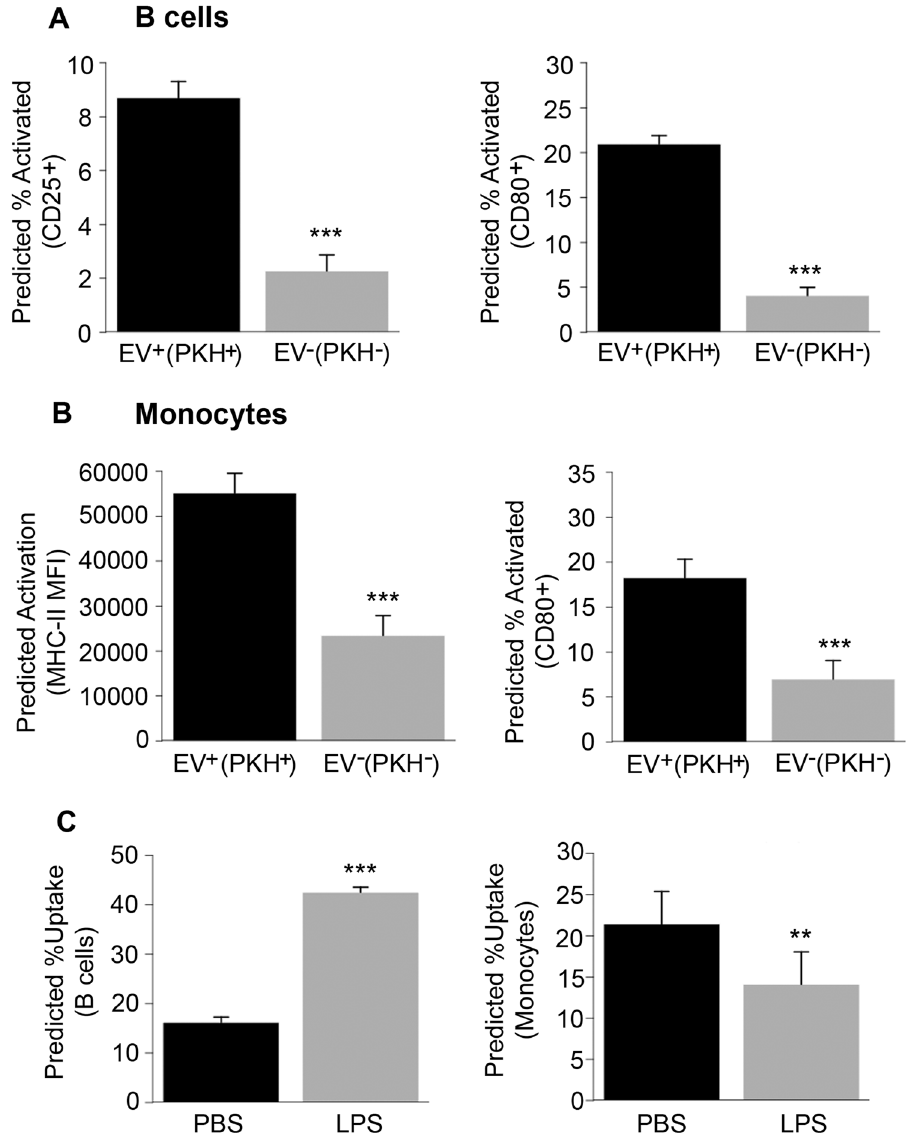
Figure 4. B cell and monocyte activation and EVs. ( A ) Plasma EVs (n = 54 EV donors) from young, middle- aged and older individuals were incubated with a different PBMC donor for 24 hrs and analyzed by FACS. ( B ) cells (CD19 + ) and monocytes (CD11b + CD14 + CD15 − ) were stained with activation markers CD80, CD25 and MHC-II. B cell percentage that express CD25 or CD80 and were positive for EV uptake (CD19 + PKH + CD25 + or CD19 + PKH + CD80 + ) were compared to the B cell percentage that express CD25 or CD80 but were not positive for EV uptake (CD19 + PKH − CD25 + or CD19 + PKH − CD80 + ). ( B ) Monocytes that express MHC-II or CD80 and interacted with EVs (CD11b + PKH + MHC-II + or CD11b + PKH + CD80 + ) was compared to the monocyte percentage that express MHC-II but did not interact with EVs (CD11b + PKH − MHC-II + or CD11b + PKH − CD80 + ). ( C ) PBMCs from above were treated with LPS or PBS for 2 hrs then EVs (n = 23 a subset of EV donors from A-B) were added for 24 hrs followed by FACS. B cell percentage is shown for (CD19 + PKH + ) and monocyte percentage for (CD11b + PKH + ). The histograms are the value from 54 EV samples for A-B and 23 EV samples for C predicted from linear mixed model regression accounting for matching + 95% confidence interval. *** P < 0.001 and ** P <